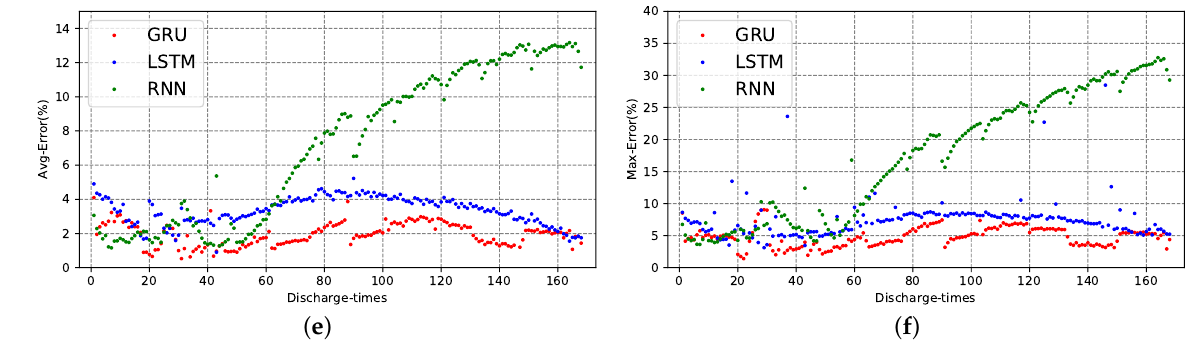
Figure 15. Estimation results of different networks. ( a ) Average error of SOC estimation for DNN networks without time series. ( b ) SOC estimation average error for GRU without consider battery aging. ( c ) Average error of SOC estimation of GRU and proposed network. ( d ) Maximum error of SOC estimation of GRU and proposed network. ( e ) Average error of the proposed network under different RNN structures. ( f ) Maximum error of the proposed network under different RNN structures.